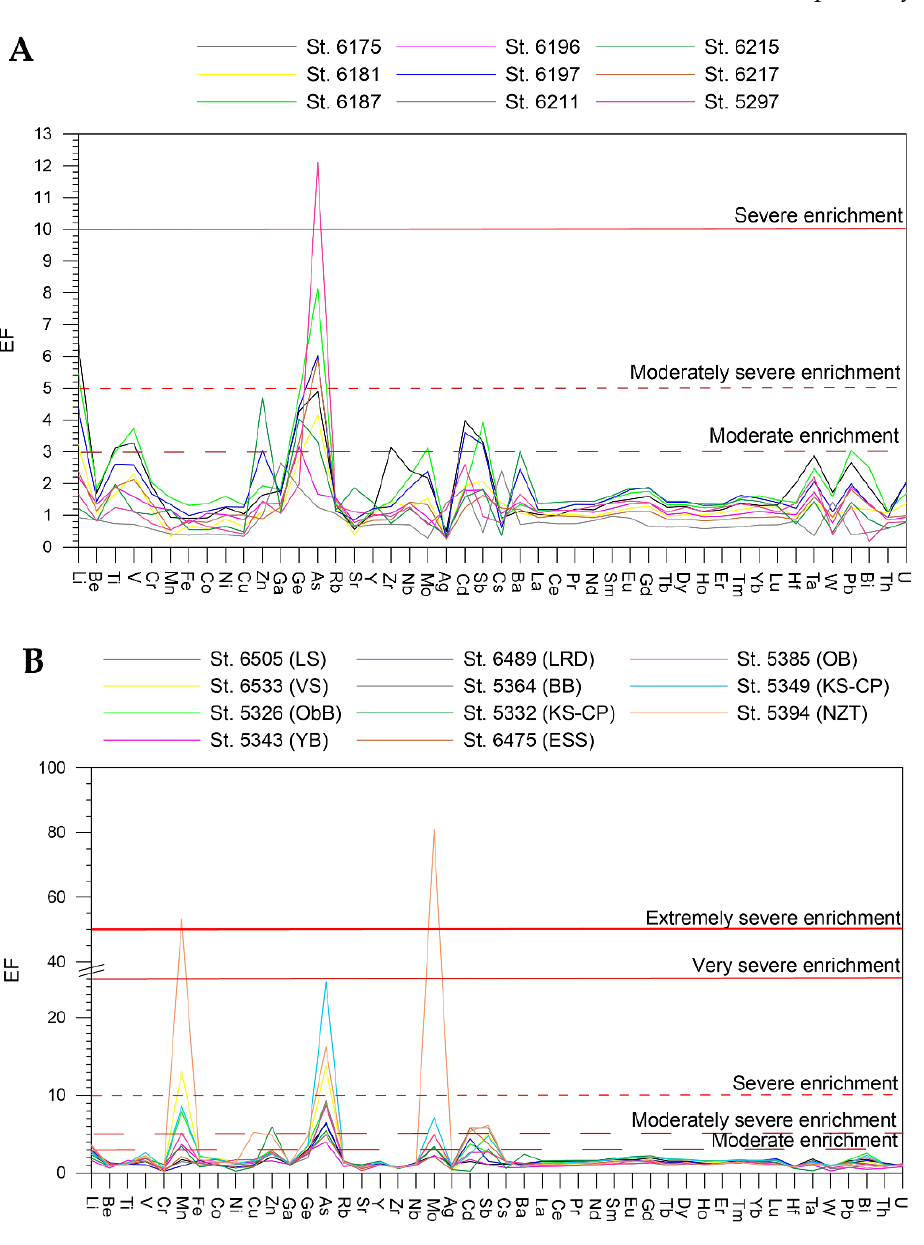
Figure 4. Enrichment factor of chemical elements in surface bottom sediments from the Barents Sea ( A ) and Kara, Laptev and East Siberian Seas ( B ). LS—Laptev Sea VL—Vilkitsky Strait; ObB—Ob Bay; YB—Yenisei Bay; LRD—Lena River delta; BB—Blagopoluchiya Bay; KS-CP Kara Sea, central part; ESS—East Siberian Sea; OB—Oga Bay; KS-CP—Kara Sea, central part; NZT—Novaya Zemlya Trough.